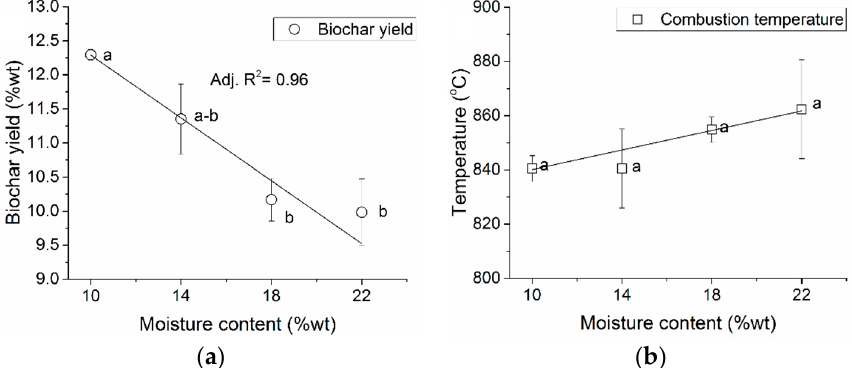
Figure 4. ( a ) Biochar yield and ( b ) combustion zone temperature of wood chips at different moisture contents (airflow 20 lpm, avg. particle size 7 mm, biomass compactness 0 kg). Different letters on data points indicate significant differences ( p < 0.05).